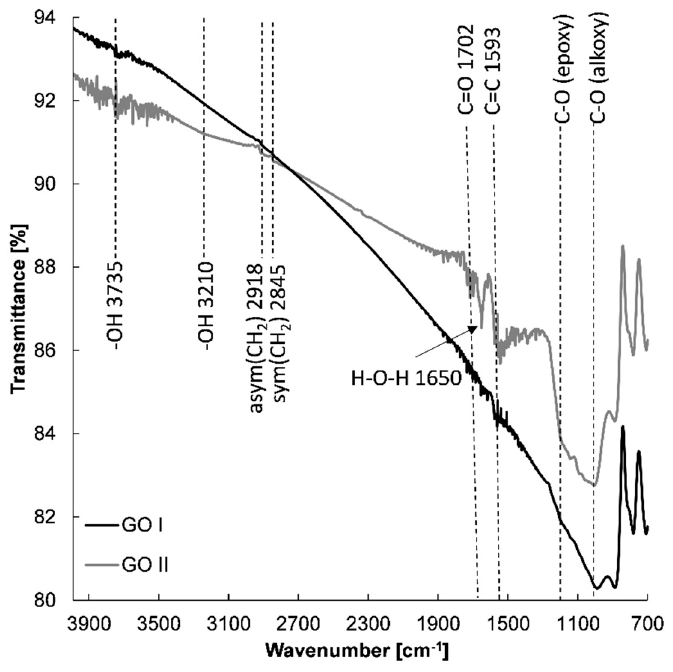
Figure 8. FTIR spectra of GO I and GO II.